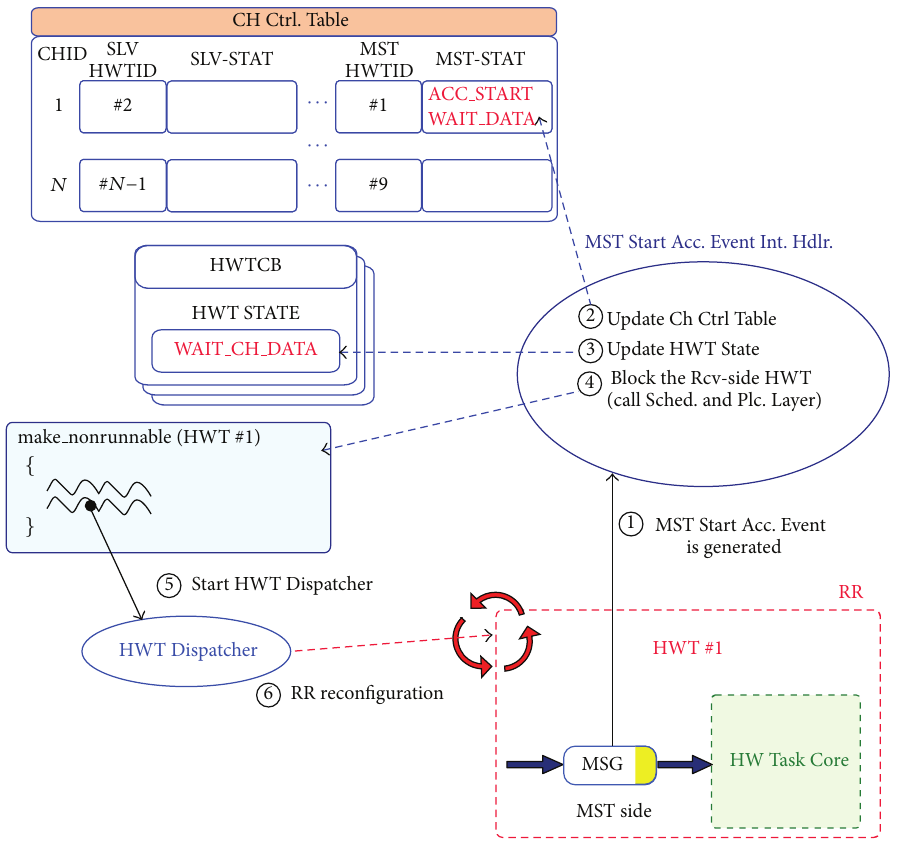
Figure 15: Channel event processing example—MSG read-side channel